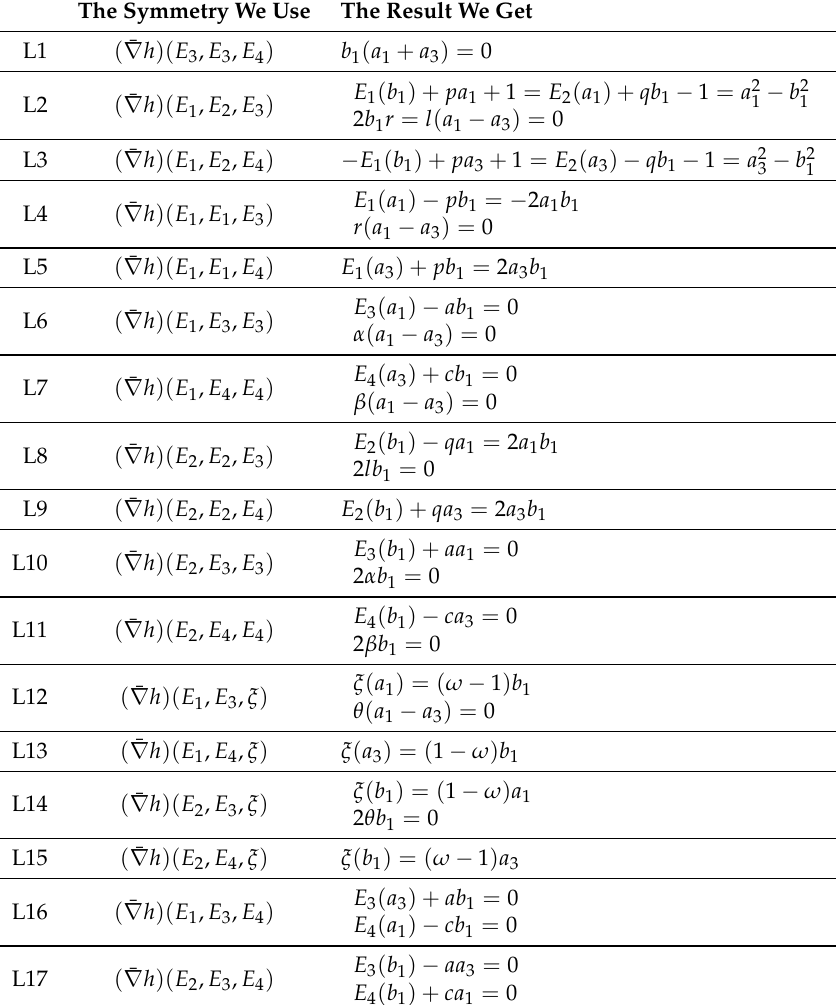
Table 2. Gauss equations and symmetries of ¯ ∇ h